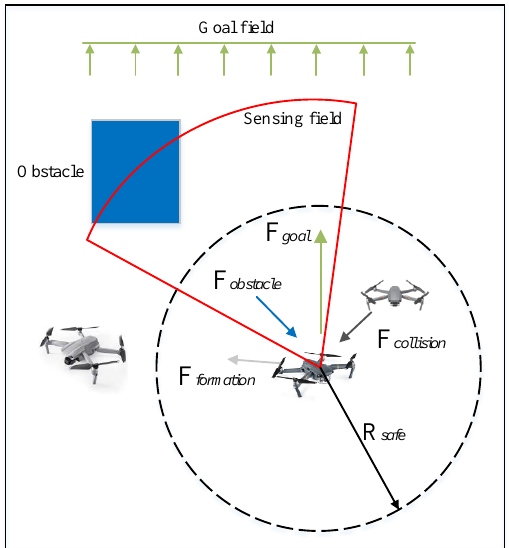
Figure 12. Artificial Potential Field